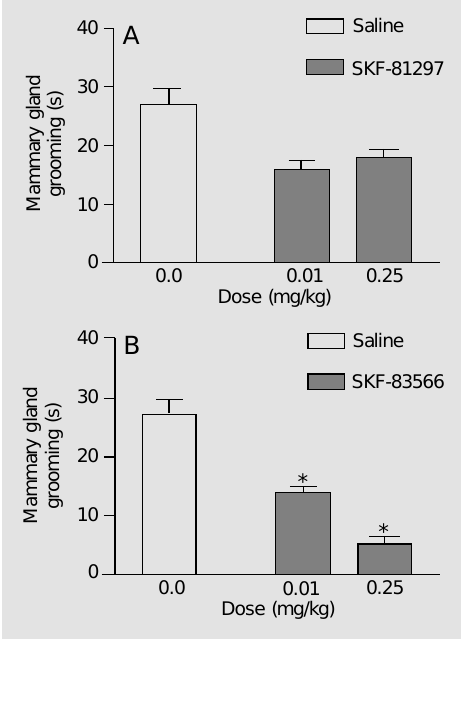
Figure 2. Effects of acute sc treatment with the D2-like re- ceptor agonist lisuride (A) and antagonist sulpiride (B) on the duration of self-grooming of the mammary glands in 7-9-day pregnant rats. *P<0.05 com- pared to the saline-treated group (ANOVA followed by the Tukey- Kramer